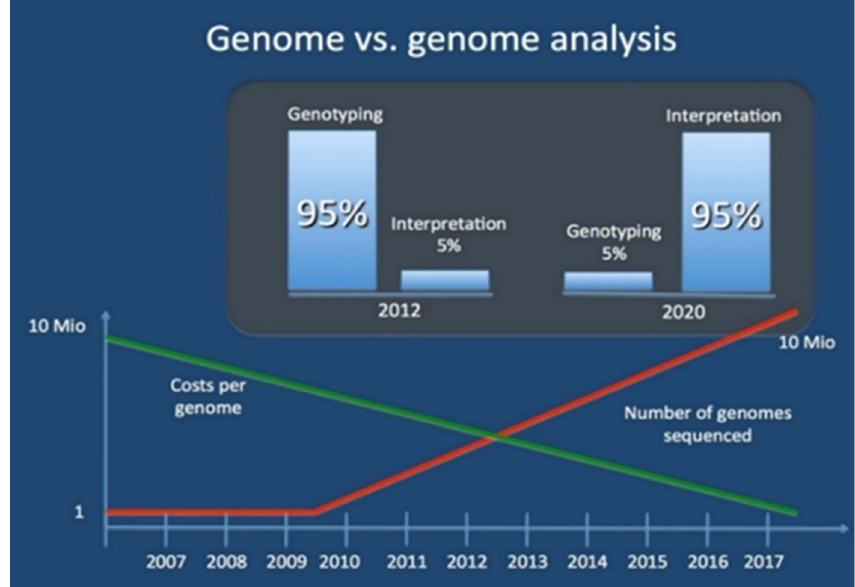
Figure 1. The genome and genome analysis reveal the decreasing cost of sequencing genomes and exponential growth of sequenced genomes, as well as the share of genomic data analysis in next few years [32].